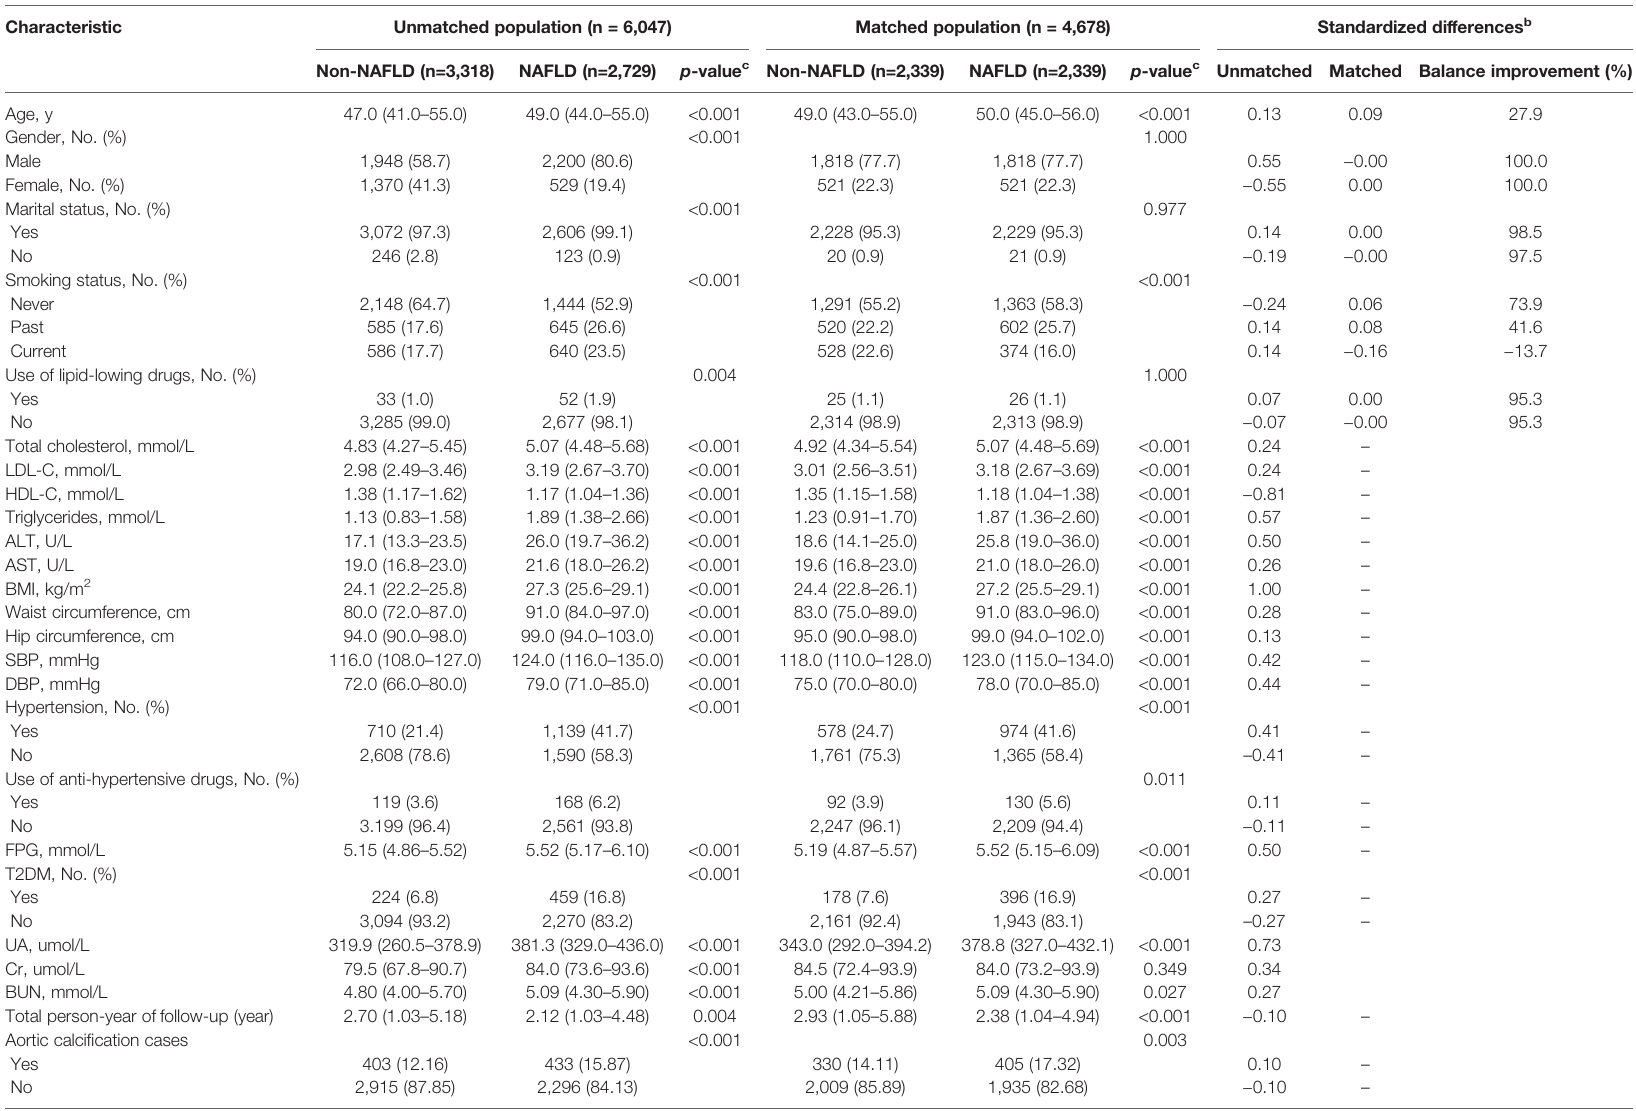
TABLE 1 | Comparison of baseline variables between participants with and without non-alcoholic fatty liver disease in the unmatched and matched population a